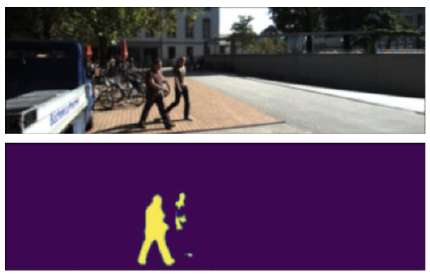
Figure 3. Blobs on instance segmentation mask